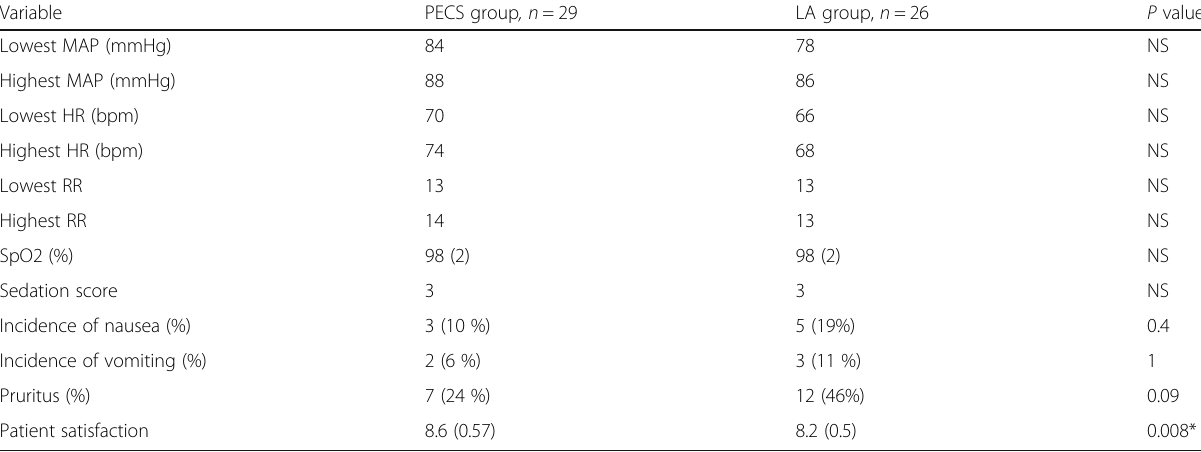
Table 4 Monitoring, postoperative complications, and patient satisfaction